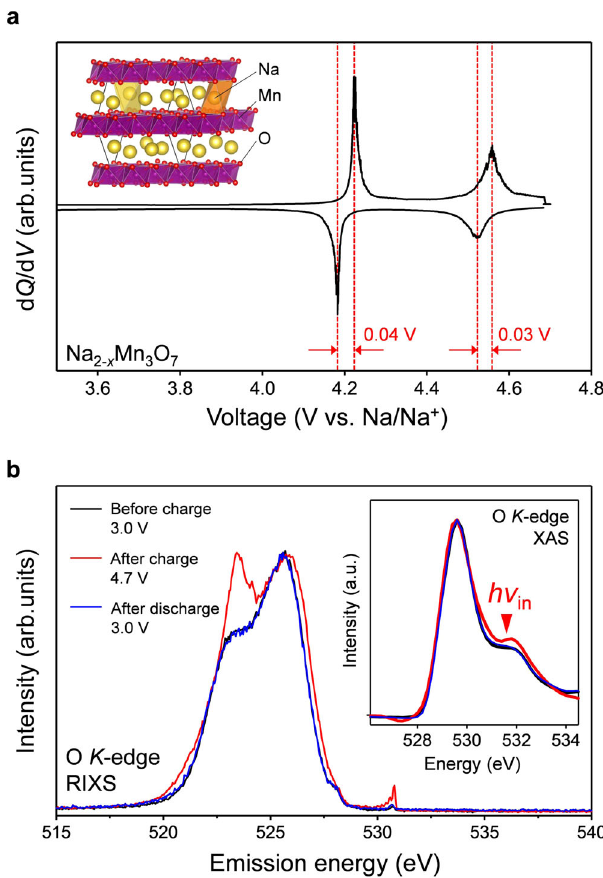
Fig. 2 Non-polarizing oxygen-redox positive electrode Na 2 Mn 3 O 7 . a d Q / d V plot ( Q : speci fi c capacity, V : reaction voltage) of Na 2- x Mn 3 O 7 at C/20 during the second charge/discharge cycle between 3.0 – 4.7 V vs. Na/Na + . Inset shows the crystal structure of Na 2 Mn 3 O 7 (yellow sphere: sodium, purple sphere: manganese, red sphere: oxygen). b O K -edge resonant inelastic X-ray scattering (RIXS) spectra for Na 2- x Mn 3 O 7 before the second charge (3.0 V, black line), after the second charge (4.7 V, red line), and after the second discharge (3.0 V, blue line) with excitation energy of 531.5 eV. Inset shows corresponding O K -edge X-ray absorption spectra